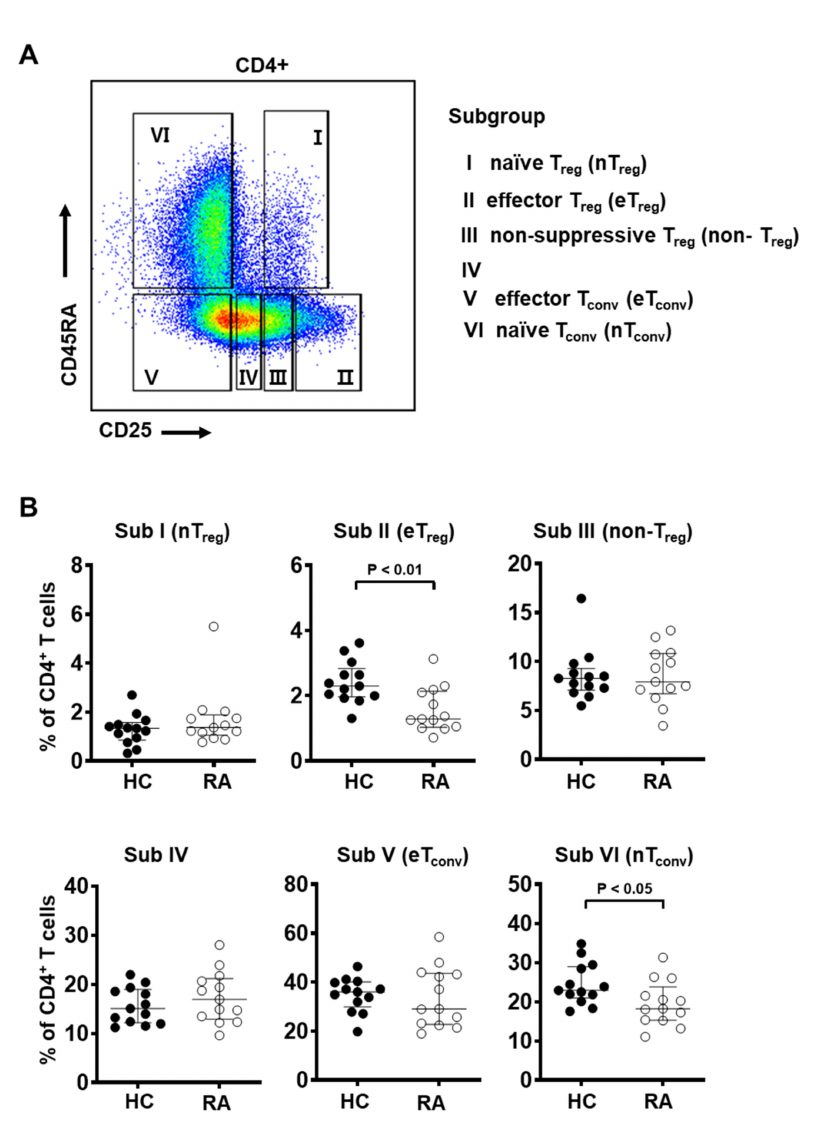
Figure 2. The frequency of effector T reg subpopulations is decreased in the peripheral blood from RA patients. ( A ) Gating strategy to identify six subgroups of CD4 + T cells based on the expression levels of CD25 and CD45RA: CD25 int CD45RA + cells (Subgroup I, naïve T reg ), CD25 hi CD45RA − cells (Subgroup II, effector T reg ), CD25 int CD45RA − cells (Subgroup III, non-suppressive T reg ), CD25 low CD45RA − cells (Subgroup IV), CD25 − CD45RA − cells (Subgroup V, effector T conv ), and CD25 − CD45RA + cells (Subgroup VI, naïve T conv ). ( B ) Frequency of each subgroup among CD4 + T cells of PBMC from healthy controls (HC, n = 13) and RA patients ( n = 13). Statistical differences between HC and RA were calculated by Mann–Whitney test and presented as p